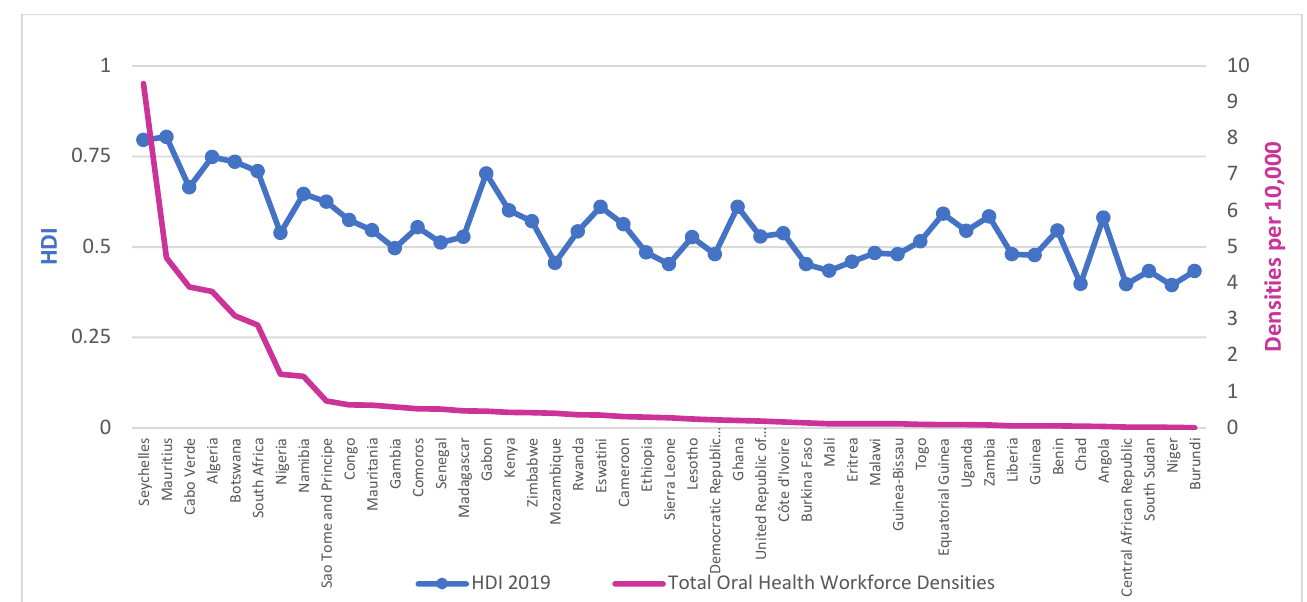
Figure 3. Densities of combined OHWF per 10,000 population and Human Development Index (HDI) for the AFR, 2019. Source: The workforce data are based on a combination of the latest available data from the NHWA data platform and King’s College London survey. HDI was collected from the latest Human Development Report from the United Nations Development Programme (UNDP).